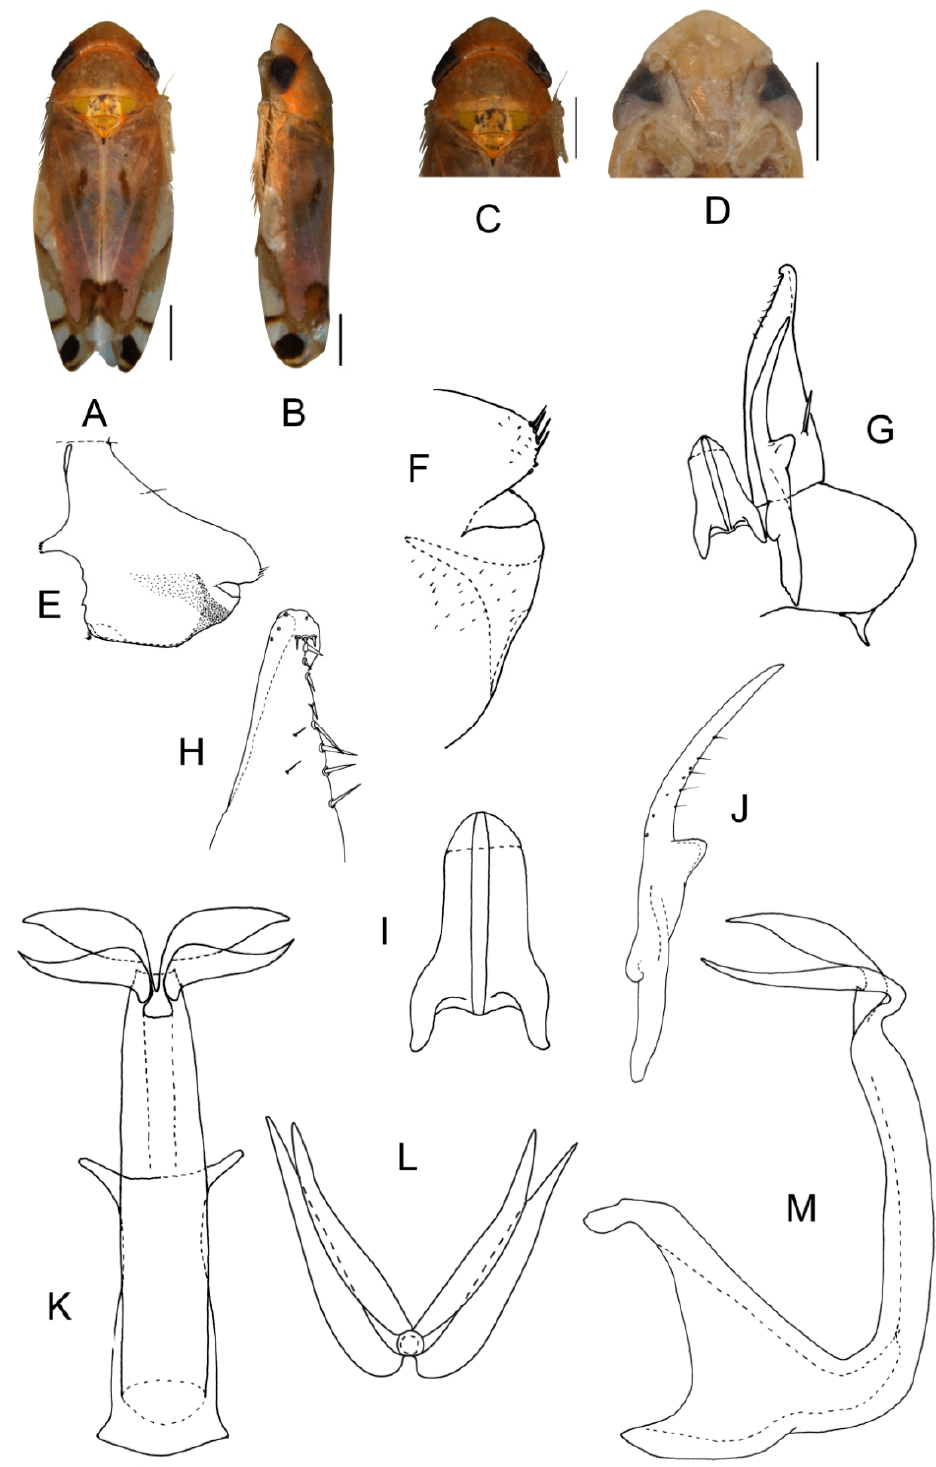
Figure 1. Eurhadina ( Singhardina ) foliiformis sp. nov. : ( A ) habitus, dorsal view; ( B ) habitus, lateral view; ( C ) head and thorax, dorsal view; ( D ) face; ( E ) male pygofer side, lateral view; ( F ) hind part of pygofer, lateral view; ( G ) subgenital plate, connective, paramere and sternite IX, dorsal view; ( H ) apex of subgenital plate, dorsal view; ( I ) connective, dorsal view; ( J ) paramere, dorsal view; ( K ) aedeagus, posterior view; ( L ) apex of aedeagal shaft, dorsal view; and ( M ) aedeagus, lateral view. Scale bars: 0.5 mm.